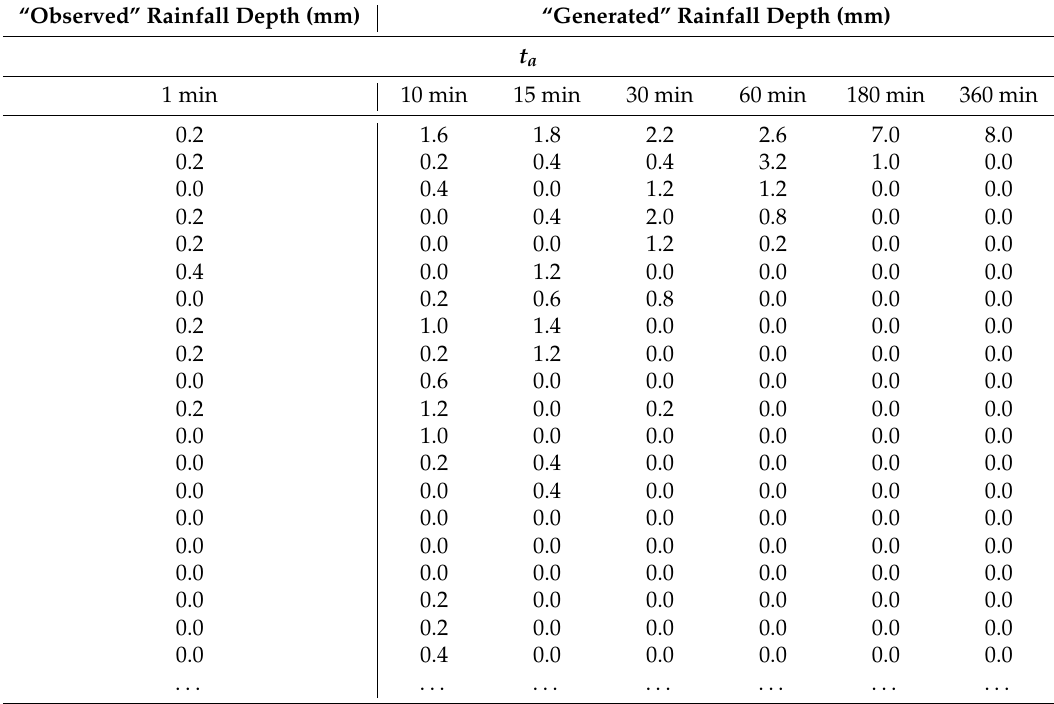
Table 2. “Observed” and “Generated” rainfall data characterized by different time resolutions, t a , starting from 3 January 2017 at 6:00 a.m. at the Gubbio rain gauge, located in the Umbria Region. “Observed” Rainfall Depth (mm)